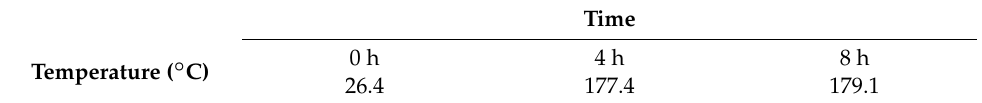
Table 1. Temperature evolution for sunflower oil samples during